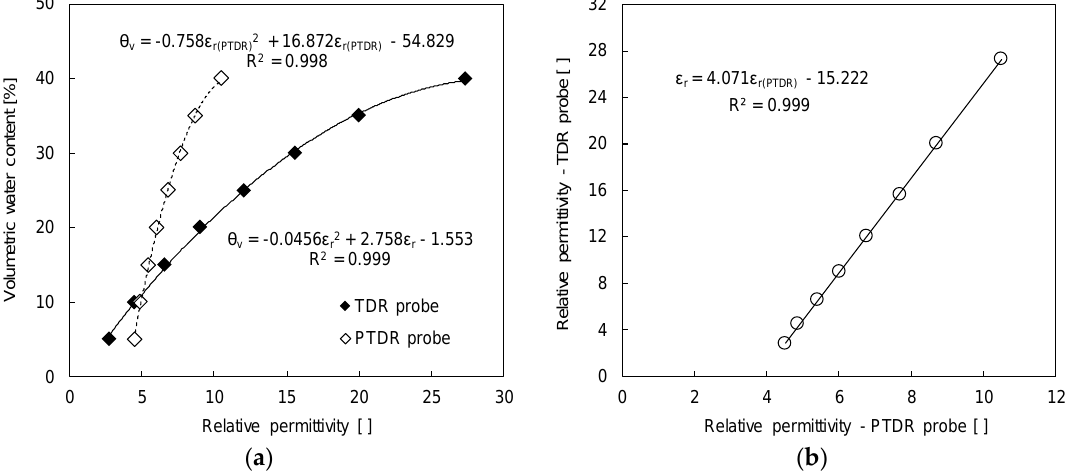
Figure 7. Signals in distilled water at different temperatures measured using the: ( a ) TDR probe; ( b ) TDCP probe.